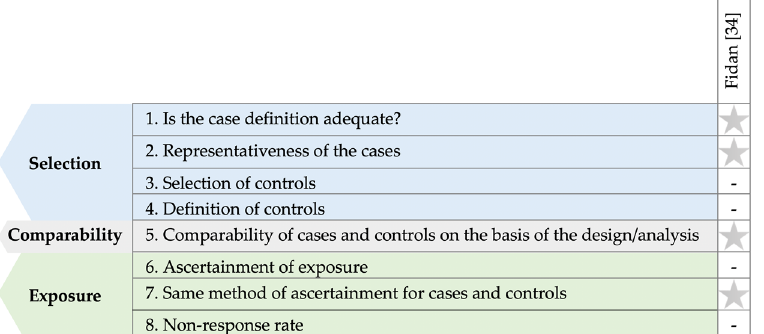
Figure 5. Summary of the quality assessment of included case-control studies using the NOS [32] tool.